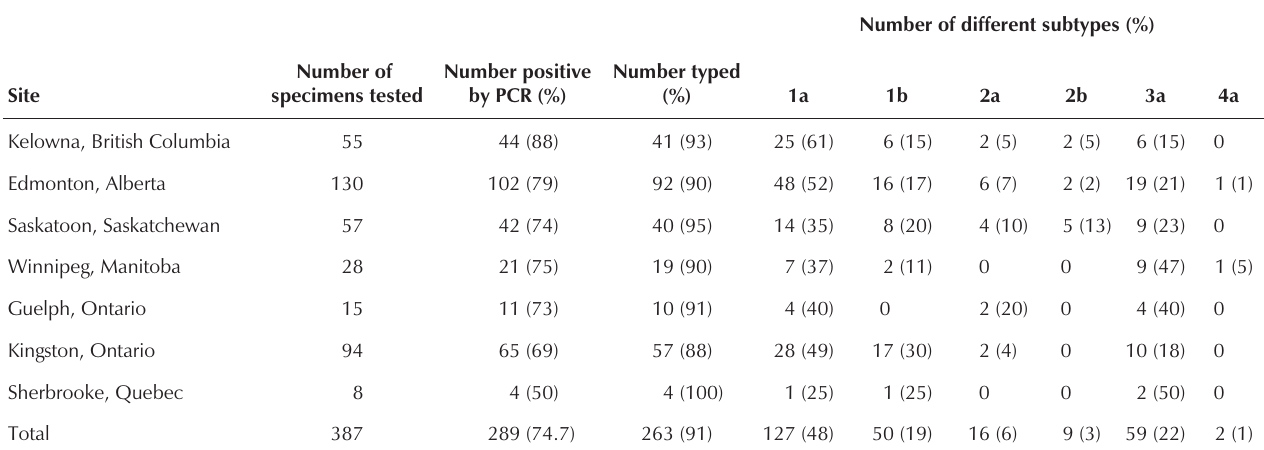
Results of hepatitis C virus subtyping from different sentinel centres participating in the Laboratory Centre for Disease Control Sentinel Health Unit Surveillance System